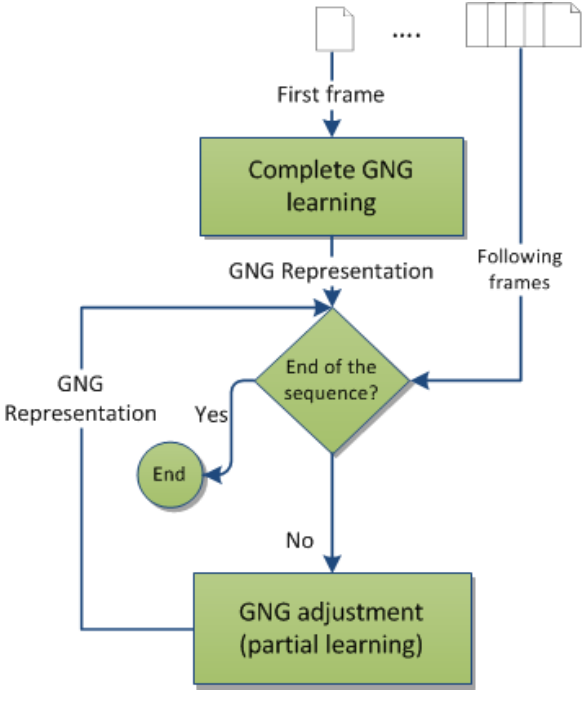
Figure 3. GNG-Seq (sequence)